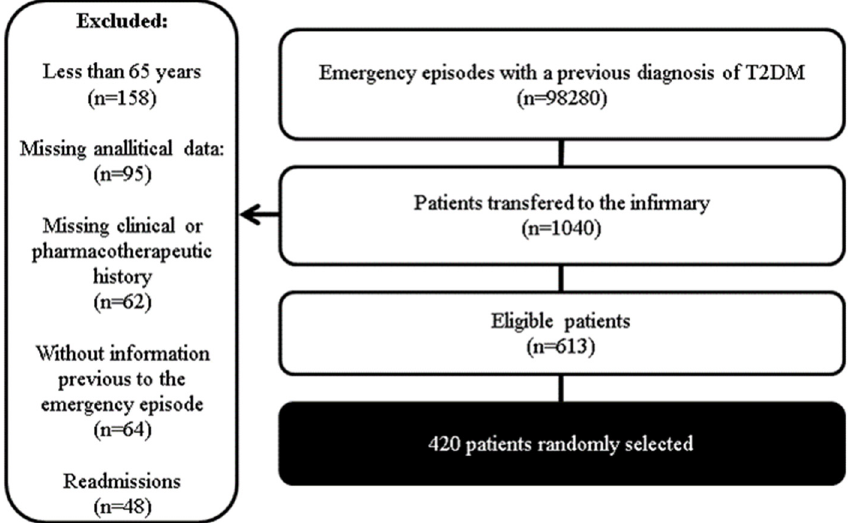
Figure 1. Sample selection.